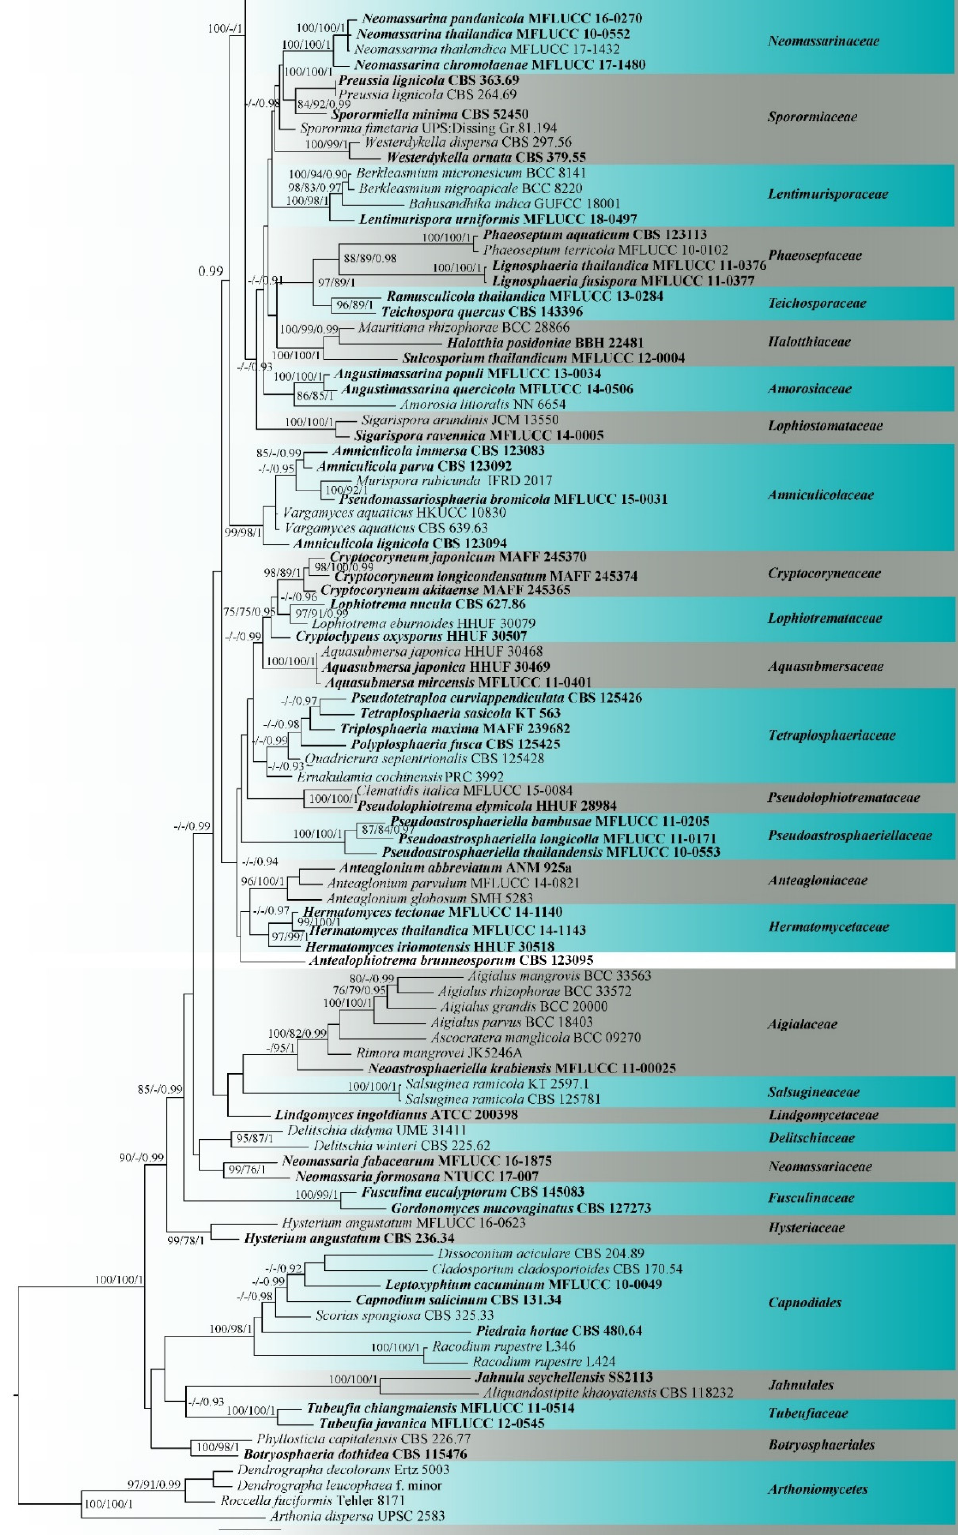
Figure 1. The best scoring RAxML tree based on a combined LSU , SSU and TEF1 α dataset. RAxML bootstrap support and maximum parsimony values ≥ 60% (BT), as well as Bayesian posterior probabilities ≥ 0.90 (BYPP) are shown, respectively, near the nodes. The ex-type strains are in bold and the scale bar indicates 0.06 changes per site. The tree is rooted with species of Arthoniomycetes and the new taxon is indicated in blue.